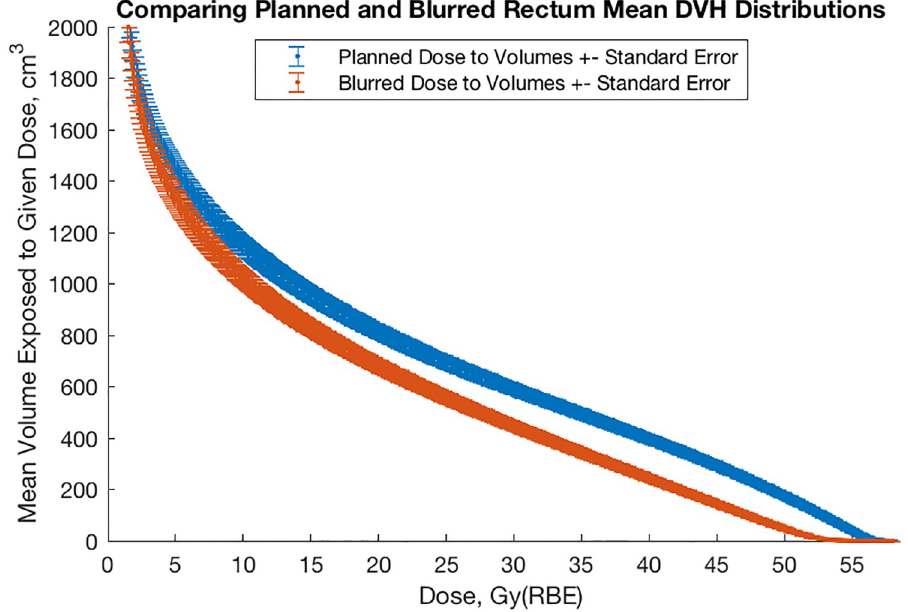
Fig 9. Comparison of mean planned and blurred rectum DVH for 40 CIRT patients.